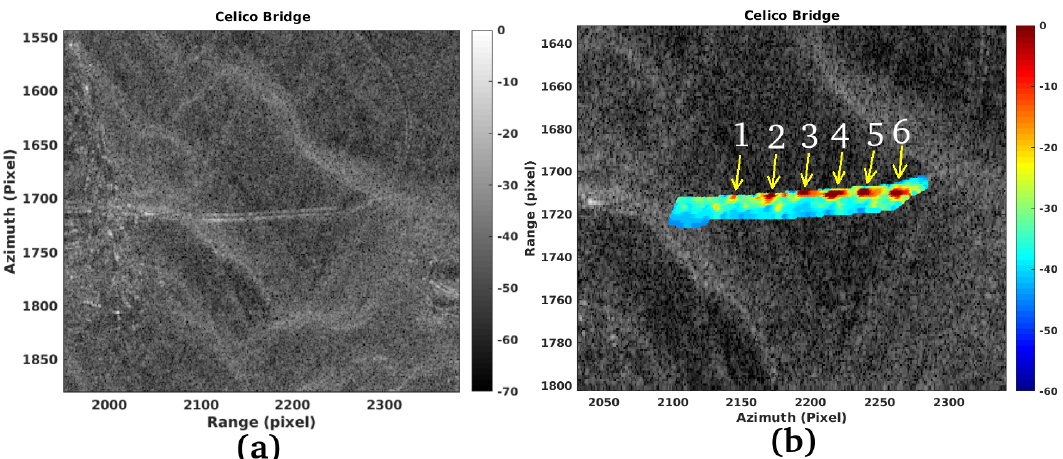
Figure 11. ( a ) Celico bridge, SAR SLC magnitude, ( b ) Vibration map of the Celico bridge.